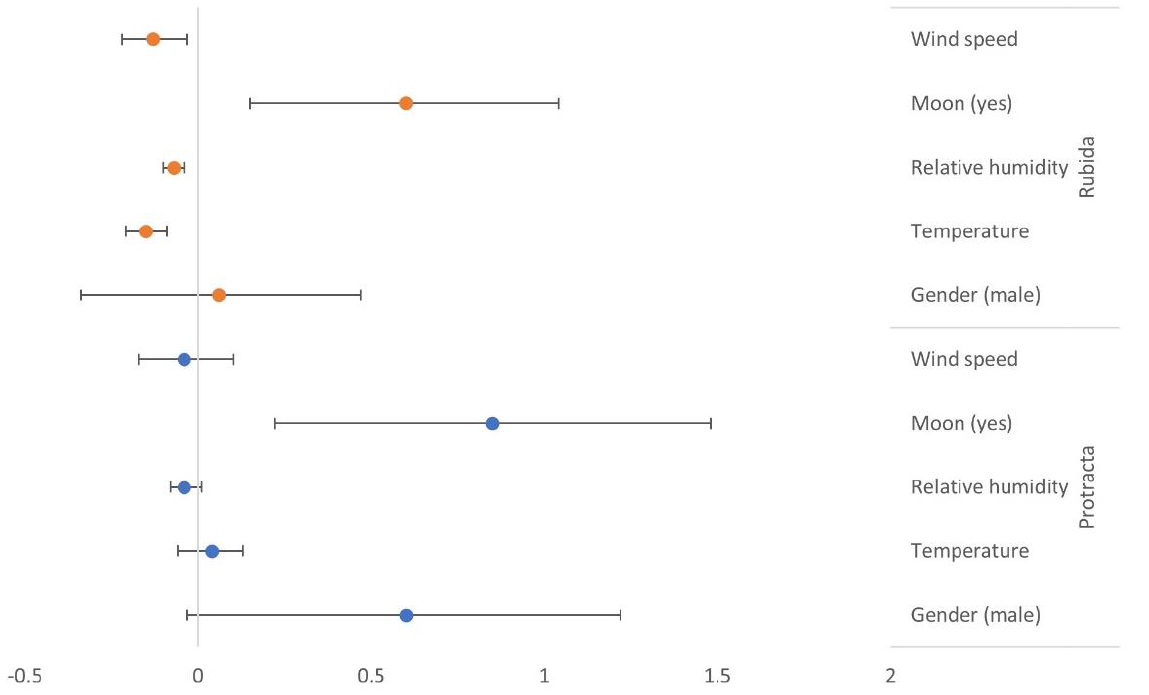
Figure 2. A forest plot of the log-count of kissing bugs and 95% confidence intervals for explanatory variables of wind speed, moon visibility, relative humidity (%), outside temperature and gender of